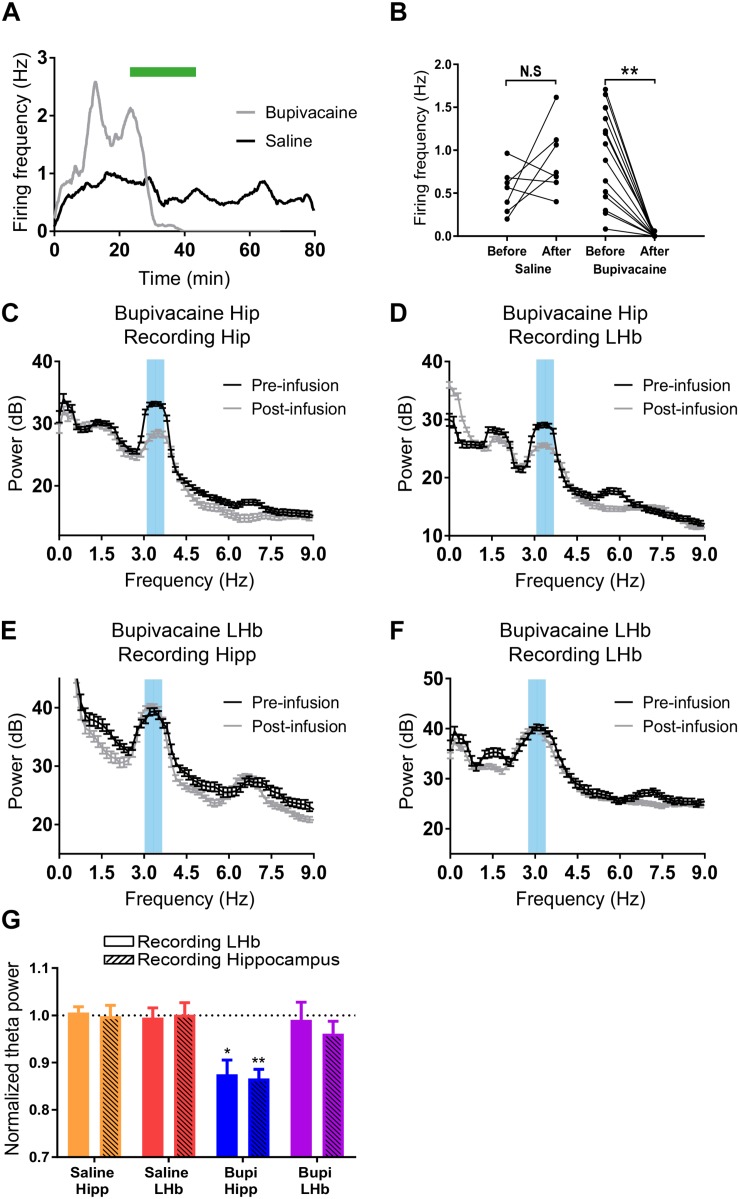
(A) Example of the firing rate over time of two hippocampal neurons before, during, and after infusion of saline (black), or bupivacaine (gray). (B) Summary of all neurons recorded during saline (N = 7, two animals) and bupivacaine infusion (N = 15, two animals; ∗∗p < 0.001). (C,D) Example fast Fourier transform (FFT) from a field potential (FP) recording during theta at the hippocampus (C) and at the LHb (D) before and after bupivacaine injection at the hippocampus. (E,F) Example FFT from an FP recording during theta at the hippocampus (E) and at the LHb (F) before and after bupivacaine injection at the LHb. In all cases, data are presented as power ± confidence interval of the FFT. (G) Summary of data presented as theta power after infusion normalized to theta power before infusion. Saline infusion does not affect theta power (hippocampus infusion: 1.06 ± 0.01 and 1.00 ± 0.02 for the hippocampus and the LHb, respectively, N = 3; LHb infusion: 0.99 ± 0.02 and 1.00 ± 0.03 for the hippocampus and the LHb, respectively, N = 4). Bupivacaine infusion at the hippocampus reduced theta power at both the hippocampus and the LHb (0.87 ± 0.03 and 0.87 ± 0.02 for the hippocampus and the LHb, respectively, N = 3; ∗∗p < 0.01, ∗p < 0.05 compared to theta power before infusion). In contrast, bupivacaine infusion at the LHb did not affect theta power at either structure (0.99 ± 0.04 and 0.961 ± 0.026 for the hippocampus and the LHb, respectively, N = 5).